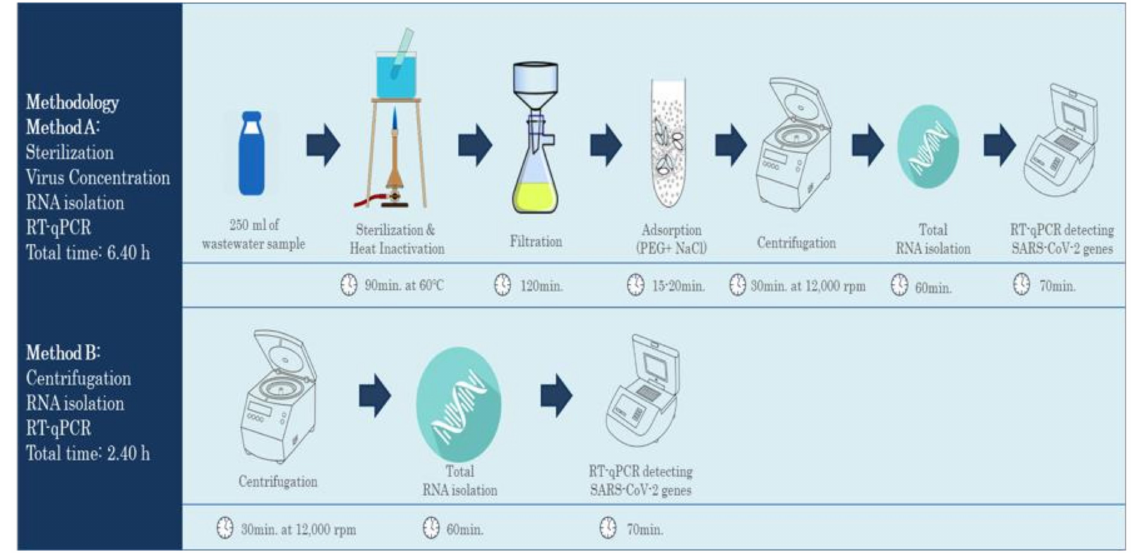
Figure 2. Methodology for the detection of SARS-CoV-2 viral genome through RT-qPCR in wastewater